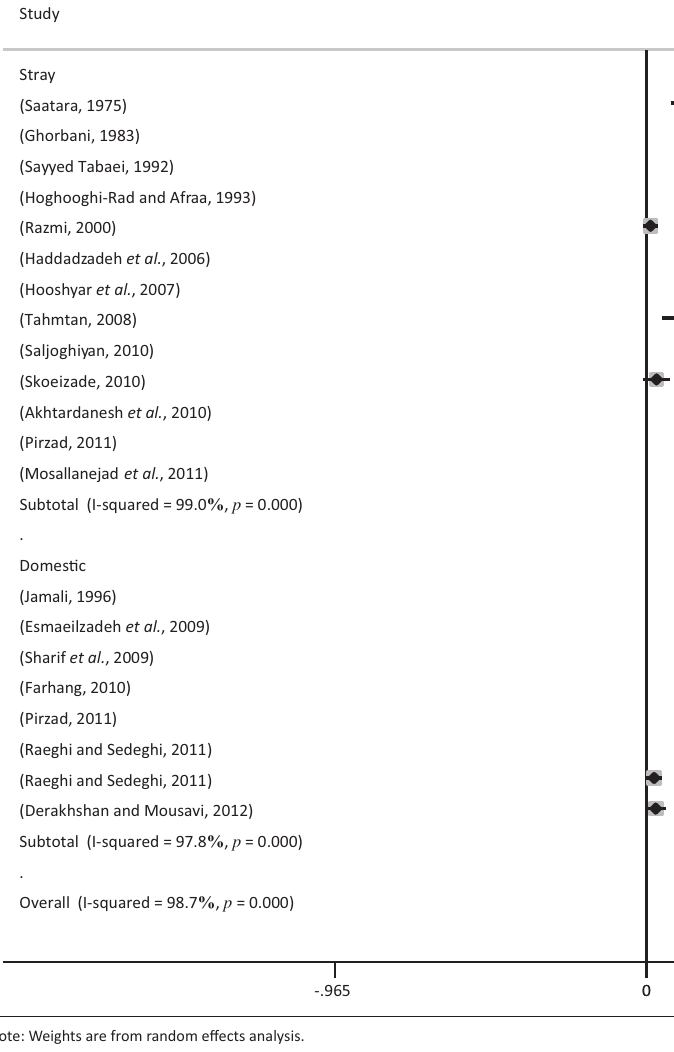
FIGURE 4: Prevalence of seropositivity in terms of type of cats (stray or